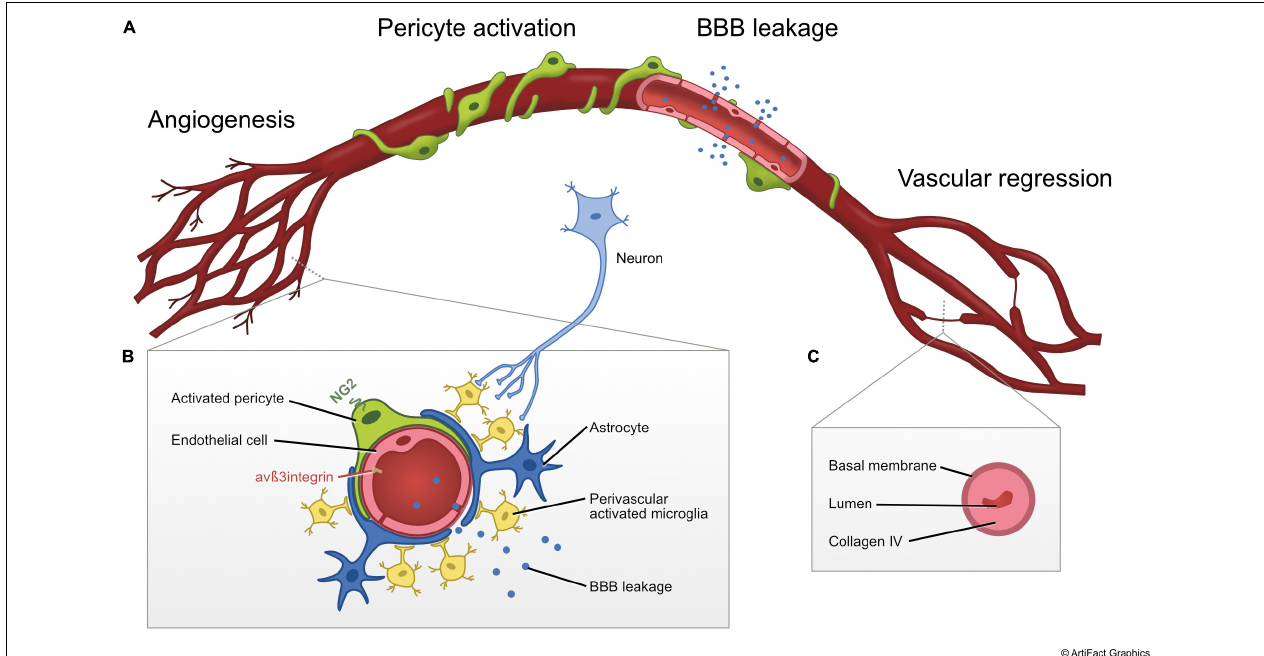
FIGURE 1 | Illustration of vascular changes observed in post mortem tissue and preclinical models of PD. (A) Simplified diagram illustrating the main vascular alterations in non-chronological order including (1) angiogenesis, (2) pericyte activation, (3) BBB leakage, and (4) vascular regression. (B) Cross-sectional diagram of the NVU during the angiogenic response. (C) Cross-sectional diagram of string vessel showing the collapsed basement membrane labeled with collagen-IV and absence of endothelial cells during vascular regression stage. The process of vascular regression includes loss of pericytes and signaling between pericytes and endothelial cells, causing destabilization of endothelial cells and endothelial cell death. NG2, neuron-glial antigen